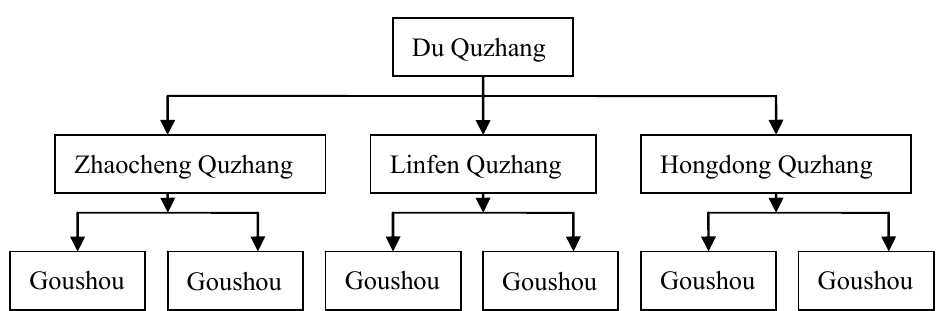
Figure 4. Organization system of Nanhuo Canal. In this water community, the